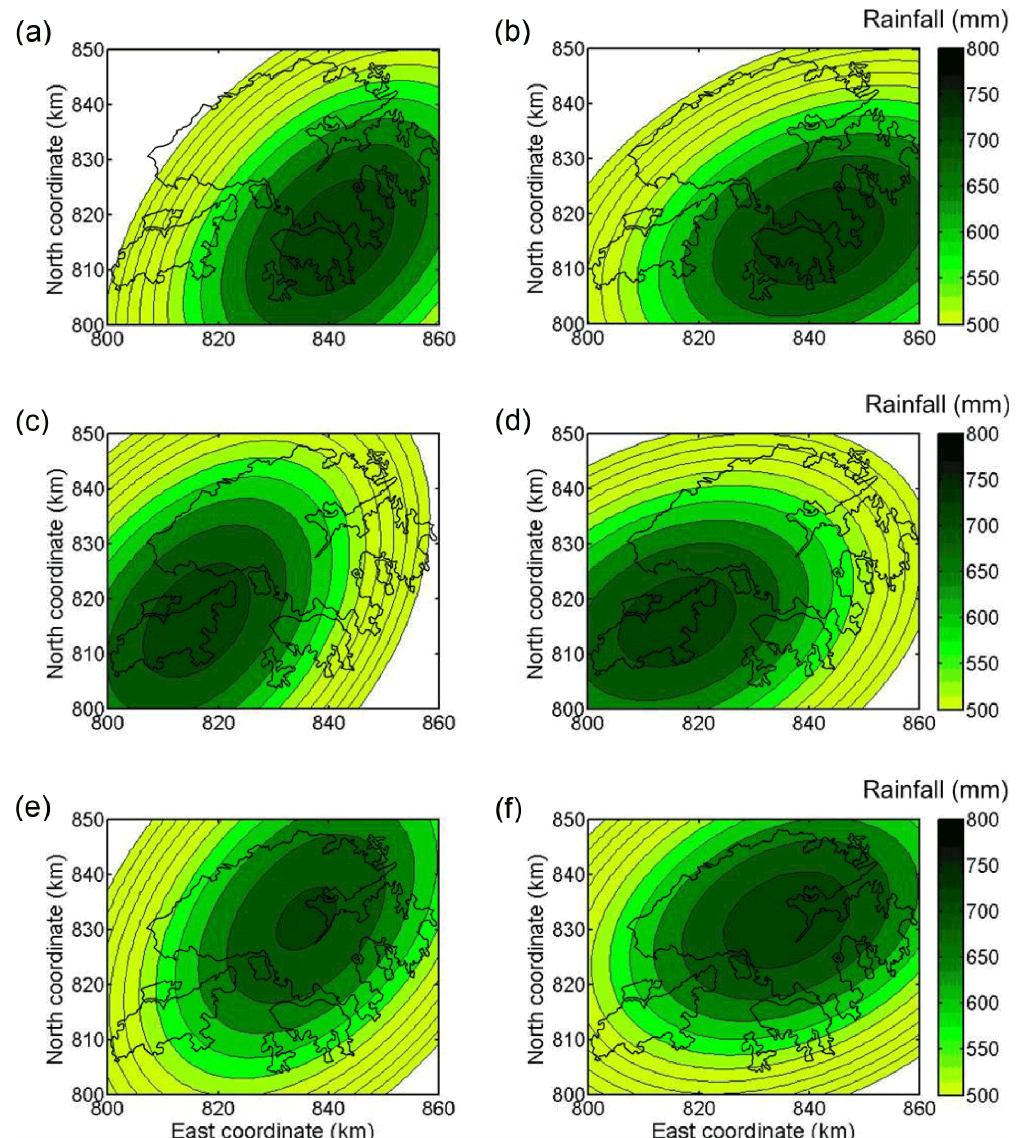
Figure 5. Trend surfaces of 24h PMP with (a) NE–SW orientation 45 ◦ ; (b) ENE–WSW orientation 22.5 ◦ centered at Hong Kong Island; (c) NE–SW orientation 45 ◦ ; (d) ENE–WSW orientation 22.5 ◦ centred at Lantau Island; (e) NE–SW orientation 45 ◦ ; and (f) ENE–WSW orientation 22.5 ◦ centred at Tai Mo Shan (modified from AECOM and Lin,